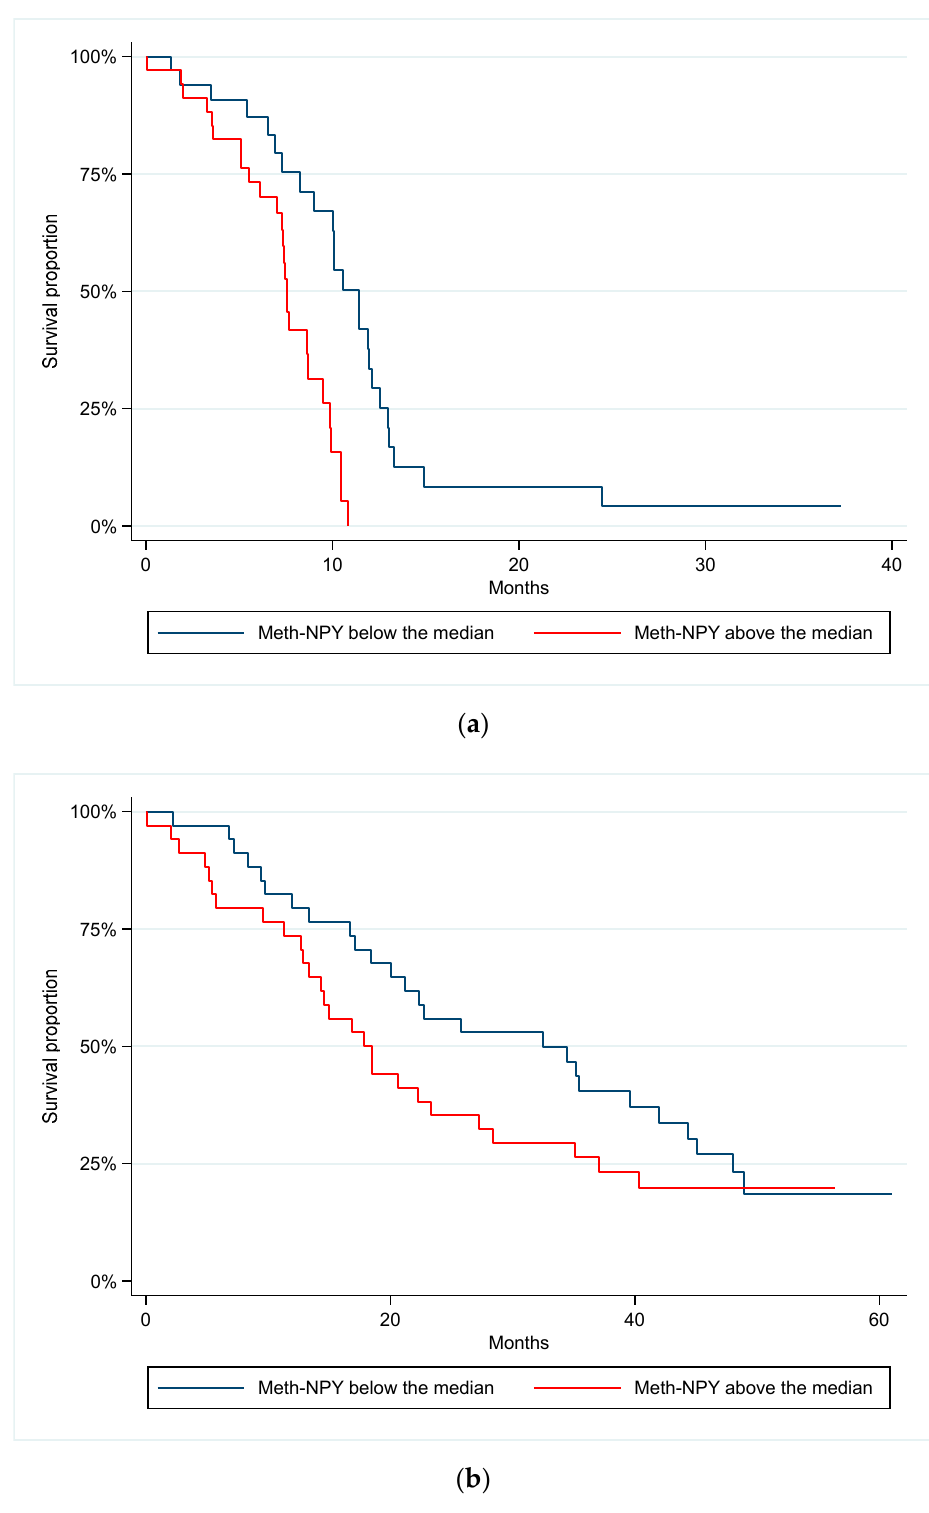
Figure 1. Kaplan–Meier plots describing ( a ) progression-free survival according to baseline level of meth-NPY above or below the median, p < 0.001, HR = 3.63 and ( b ) overall survival according to baseline level of meth-NPY above or below the median, p = 0.21, HR = 1.41.